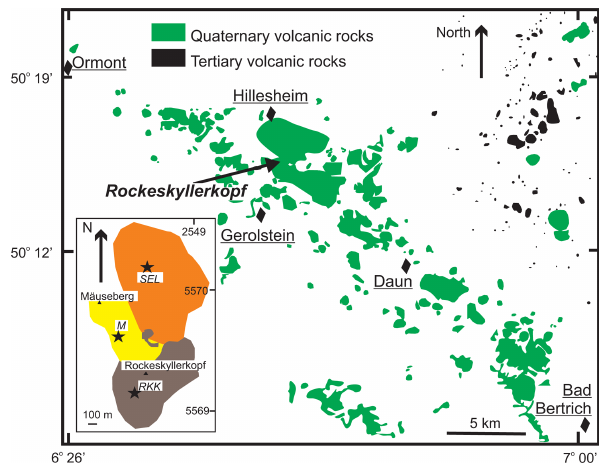
Figure 1. Distribution of Tertiary and Quaternary volcanic rocks in the West Eifel Volcanic Field. Towns are indicated by dia- monds. The distribution of the three volcanic centres in the Rock- eskyllerkopf Volcanic Complex (RVC) is shown in the inset. These are, from oldest to youngest, the SEL (South East Lammersdorf), M (Mäuseberg) and RKK (Rockeskyllerkopf) centres. Coordinates in the inset map refer to Rheinland Pfalz Topographische Karte Nr 5705 (Gauß–Krüger coordinate system). Regional geology mod- ified from Büchel (1991); geology of the RVC modified from Shaw et al.